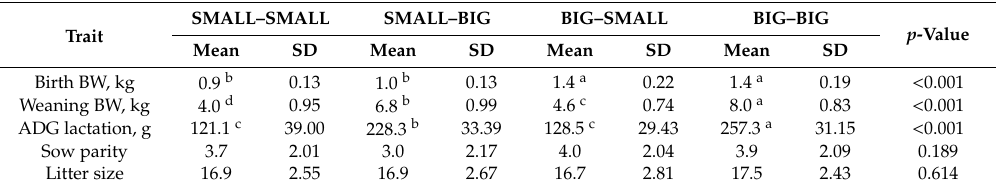
Table 1. Descriptive statistics for birth body weight (BW), weaning BW, average daily gain (ADG) during lactation, sow parity and litter size [Mean ± Standard deviation (SD)] for pigs (n = 36 per group) classified according to their birth BW as SMALL (BW ≤ 1.15 kg) or BIG (BW > 1.15 kg), and re-classified according to their weaning BW as SMALL (BW ≤ 5.5 kg) or BIG (BW > 5.5 kg), yielding a 2 × 2 factorial